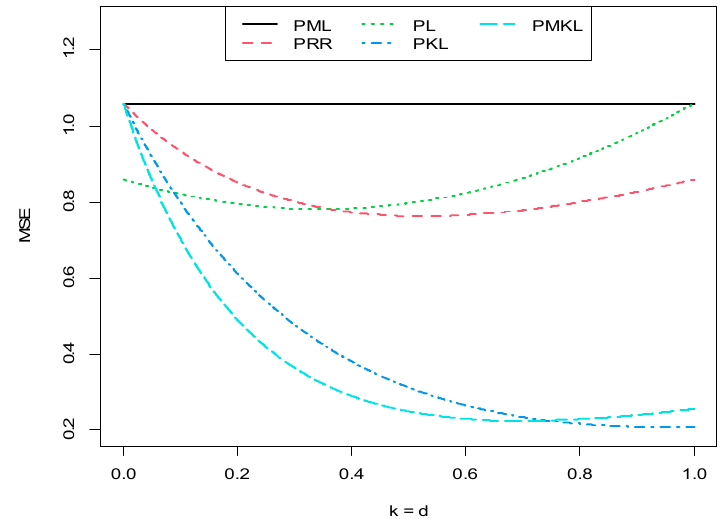
Figure 5. MSE values of the non‑robust estimators against k and d of the Somerville Lake data.